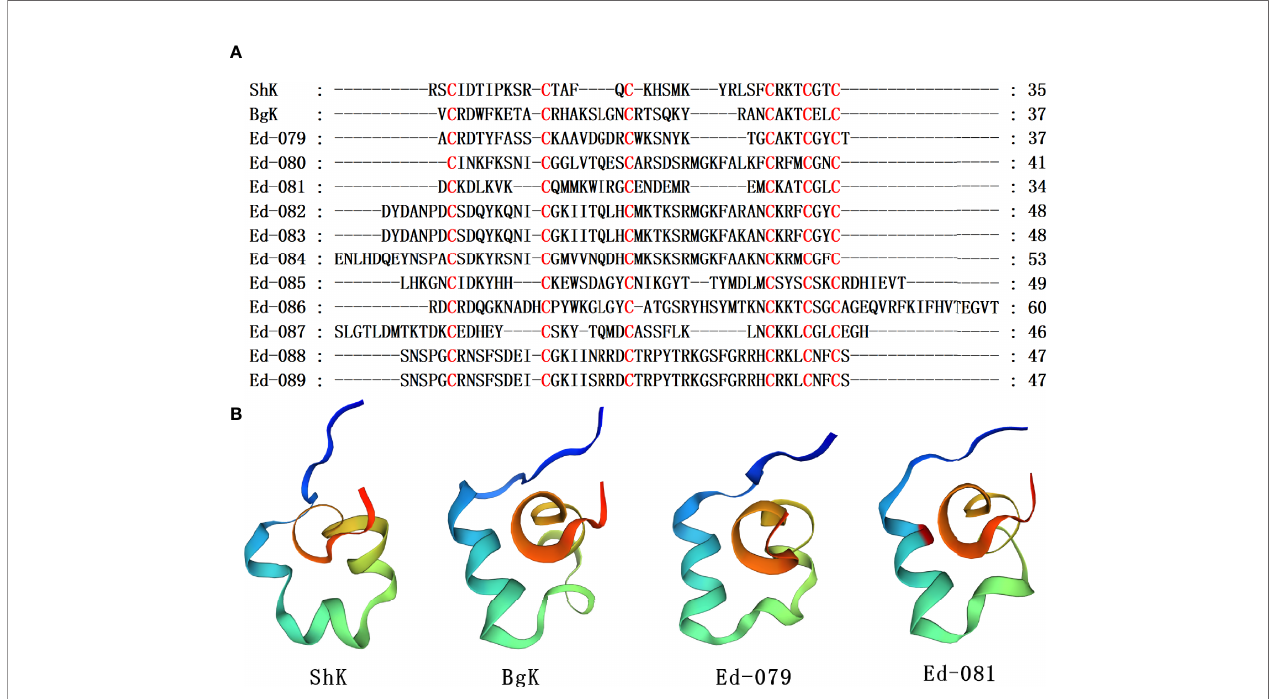
FIGURE 4 | Representative sea anemone mature peptide sequences with ShK domain. (A) Alignments of sea anemone mature peptides with ShK domain. Cysteines are highlighted in red. (B) Homology modeling prediction of the representative sea anemone mature peptide Ed-079 and Ed-081 with ShK ( k -stichotoxin- She3a, PDB 4LFQ) and BgK ( k -actitoxin-Bgr1a, PDB